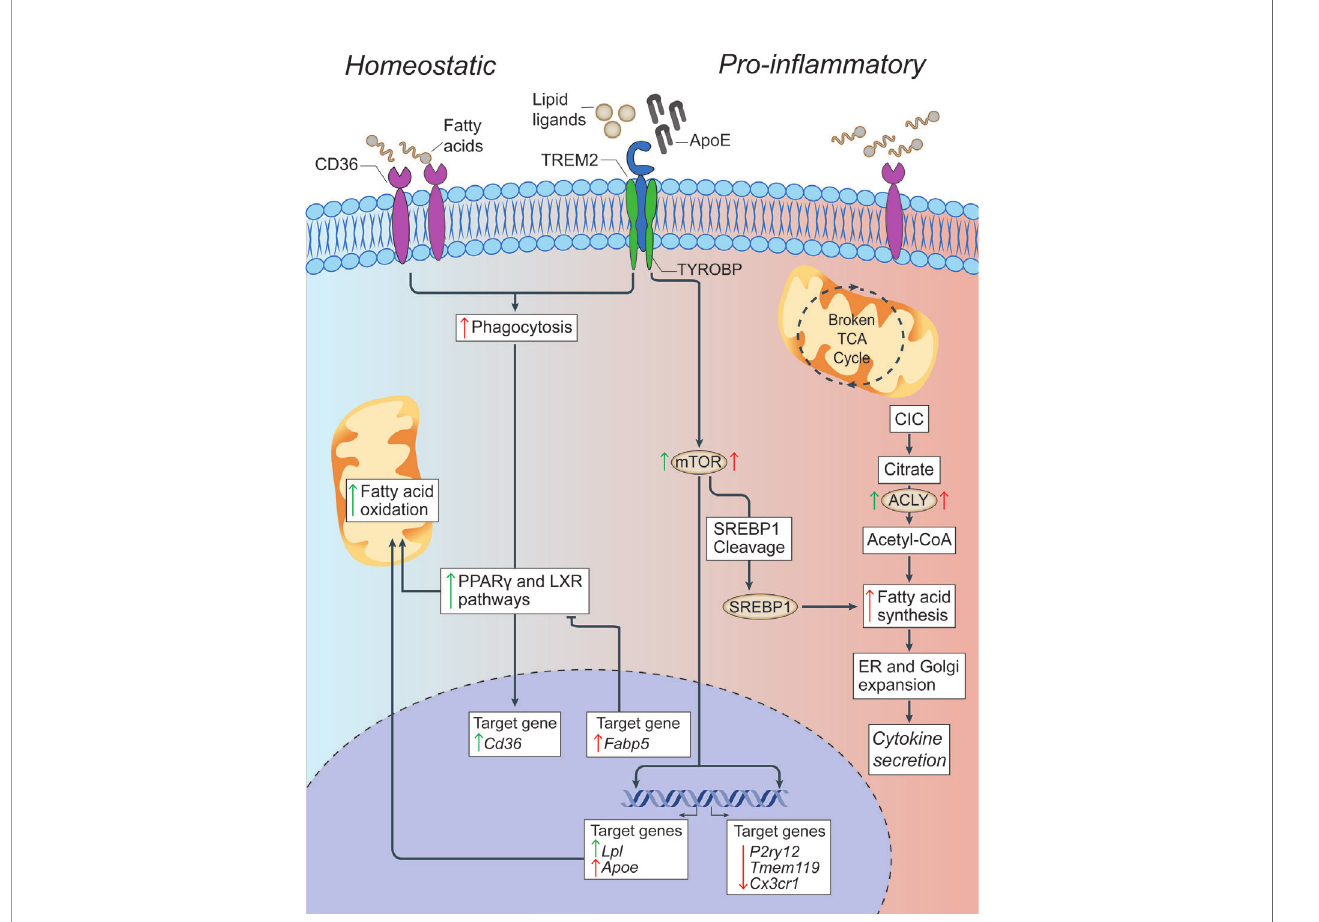
FIGURE 2 | Lipid metabolism in microglia under homeostatic and in fl ammatory conditions. In microglia, CD36 and TREM2 play a key role in the response to extracellular lipids. CD36 promotes lipid-responsive signalling pathways (like the PPAR g and LXR pathways), which in turn increase FAO and further upregulate Cd36 . TREM2 activation (via ligands such as ApoE) results in the suppression of homeostatic microglial genes ( P2ry12, Tmem119, and Cx3cr1 ), the activation of mTOR signalling, and the upregulation of lipid processing genes (such as Apoe , Lpl , and Fabp5 ). Despite mTOR increasing both FAS (through the cleavage and activation of SREBP-1) and glycolysis (which are canonically associated with a pro-in fl ammatory activation of myeloid cells), it appears that the role of TREM2 is to support correct lipid metabolism. In fact,TREM2 de fi cient microglia show the formation of intracellular cholesterol crystals that activate the in fl ammasome pathway. On the contrary, the downstream gene Fabp5 seems to play a key role in determining the pro-in fl ammatory activation of myeloid cells, possibly via inhibition of PPAR g signalling and FAO. In pro-in fl ammatory microglia, a broken TCA cycle is coupled with an upregulated mitochondrial CIC, which increases citrate export from the mitochondria to the cytosol, where it is converted into acetyl-CoA for FAS by ACLY. The resultant increase in FAS supports the expansion of the ER and Golgi, and the increased production of pro-in fl ammatory cytokines. Green arrows = homeostatic effects. Red arrows = pro-in fl ammatory effects. PPAR g , peroxisome proliferator-activated receptor g ; LXR, liver X receptor; FAO, fatty acid oxidation; mTOR, mechanistic target of rapamycin; FAS, fatty acid synthesis; ACLY, ATP citrate lyase; CIC, citrate carrier; TCA, tricarboxylic acid cycle; SREBP-1, Sterol regulatory element binding protein 1; TYROBP, TYRO protein tyrosine kinase-binding protein; TREM2, Triggering receptor expressed on myeloid cells 2; Lpl, Lipoprotein Lipase; P2ry12, Purinergic Receptor P2Y12; Tmem119, Transmembrane Protein 119, Cx3Cr, C-X3-C Motif Chemokine Receptor